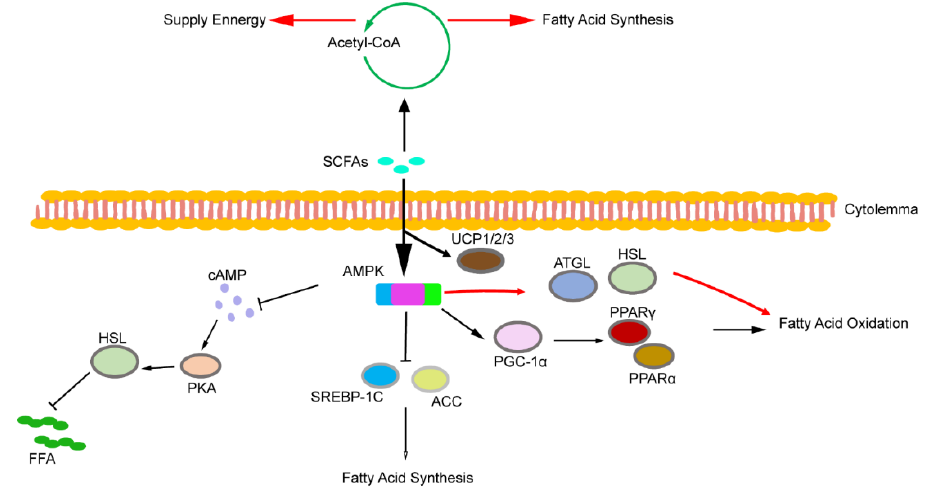
Figure 3. SCFAs regulates lipid metabolism by increasing fatty acid oxidation, reducing lipid deposition and heat production. and heat